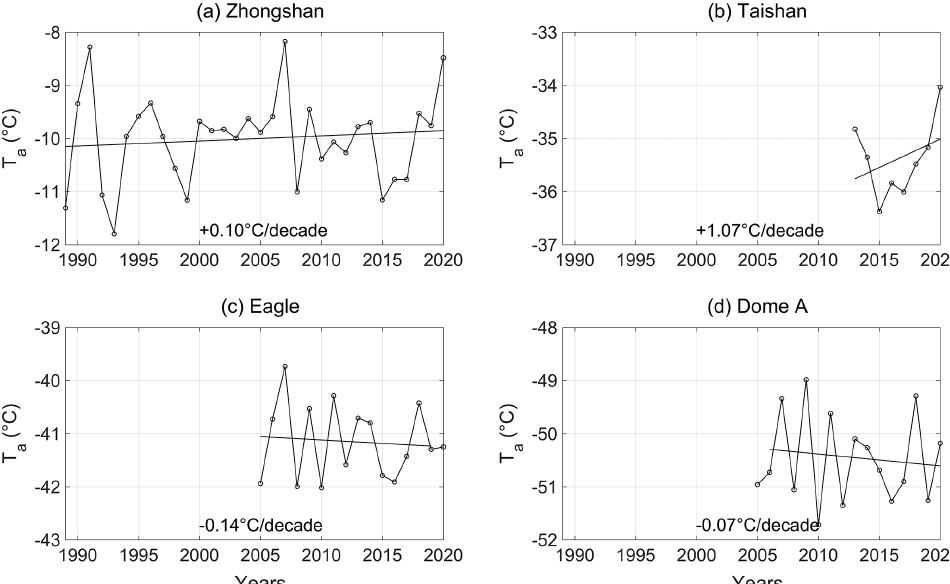
Figure 5. Interannual variation in air temperature at Zhongshan, Taishan ( p < 0.05), Eagle and Dome A. Zhongshan is calculated during 1989–2020; Taishan is calculated during 2013–2020; Eagle and Dome A are calculated during 2005–2020.